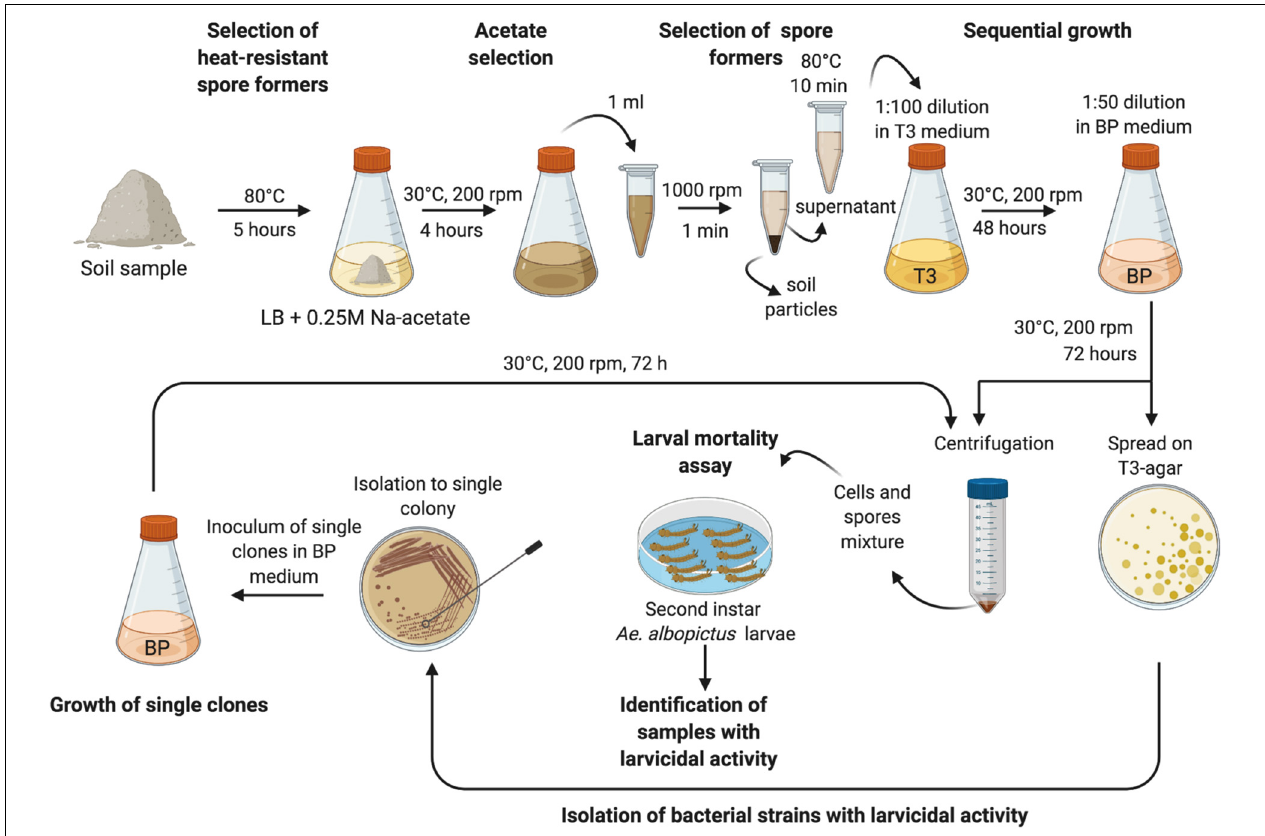
FIGURE 1 | Schematic representation of the protocol used for the identification of soil samples enriched with bacteria with insecticidal activity and for the isolation of bacterial strains with larvicidal activity against Ae. albopictus . Created with BioRender.com.